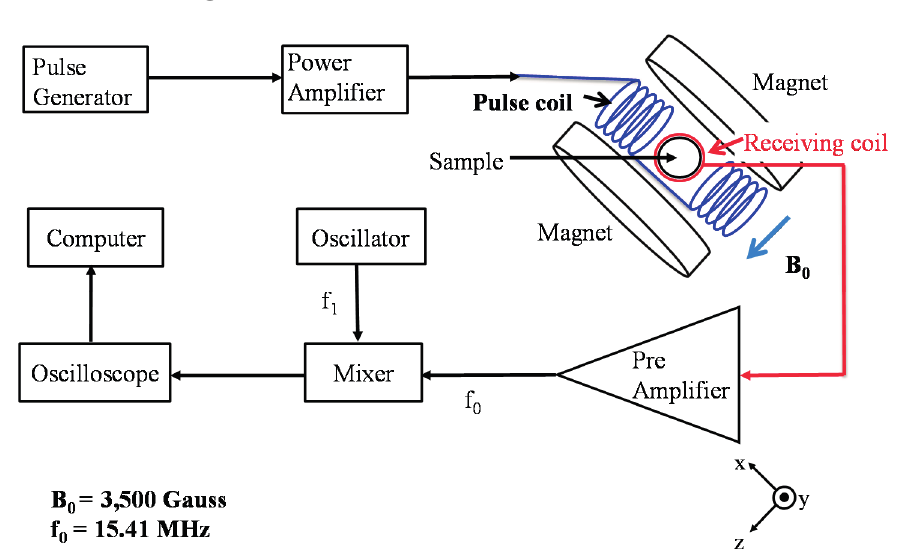
Figure 1. The schematic of the MR